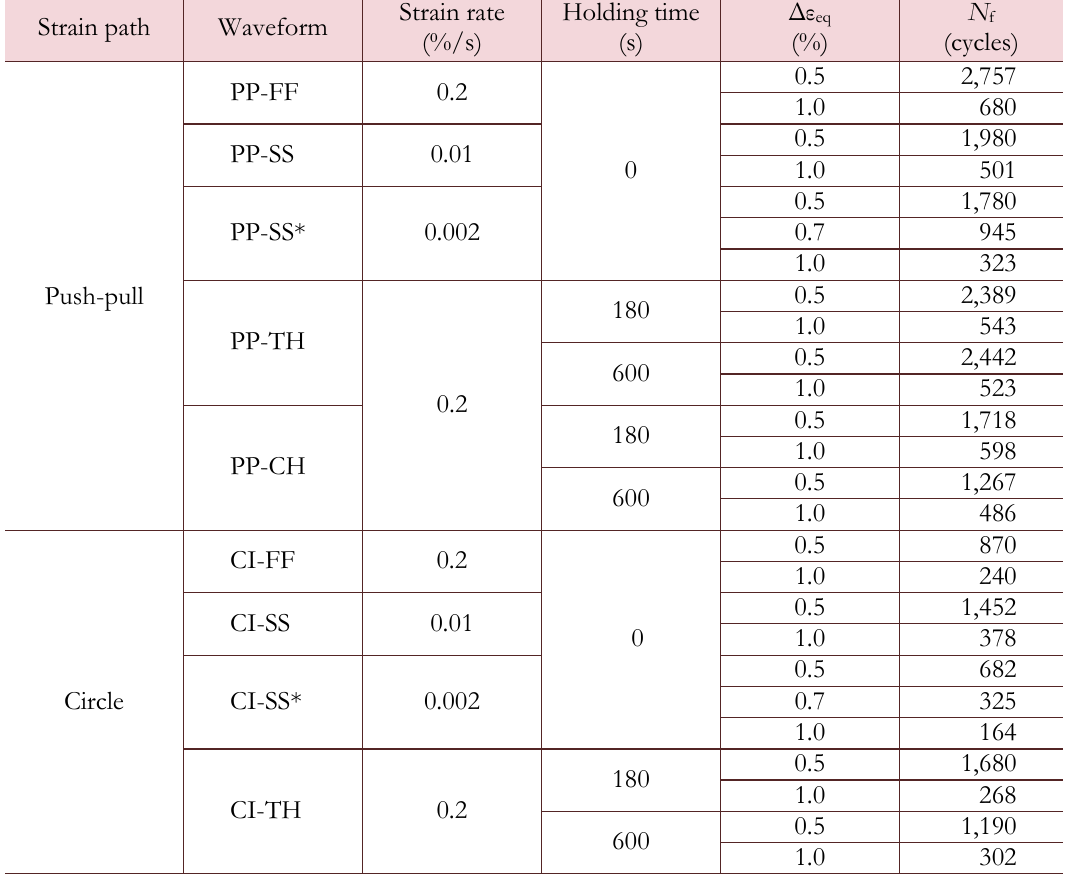
Table 1: Test conditions and